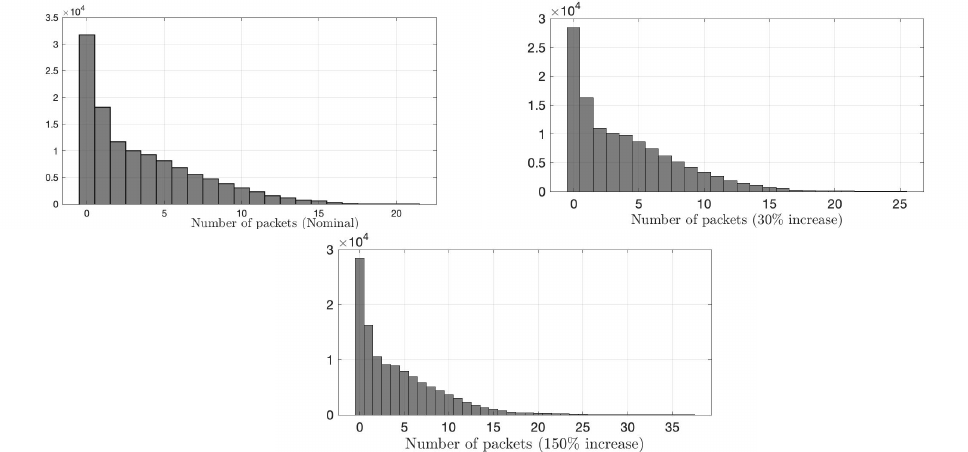
Figure 9. Histogram of number of packets for a road segment. The first histogram represents the distribution of nominal data, whereas the second and third represent attack cases with an average increase that is 0.3 and 1.5 times the baseline, respectively. Nominal and attack distributions are close to a negative binomial distribution with extended tails under attacks.